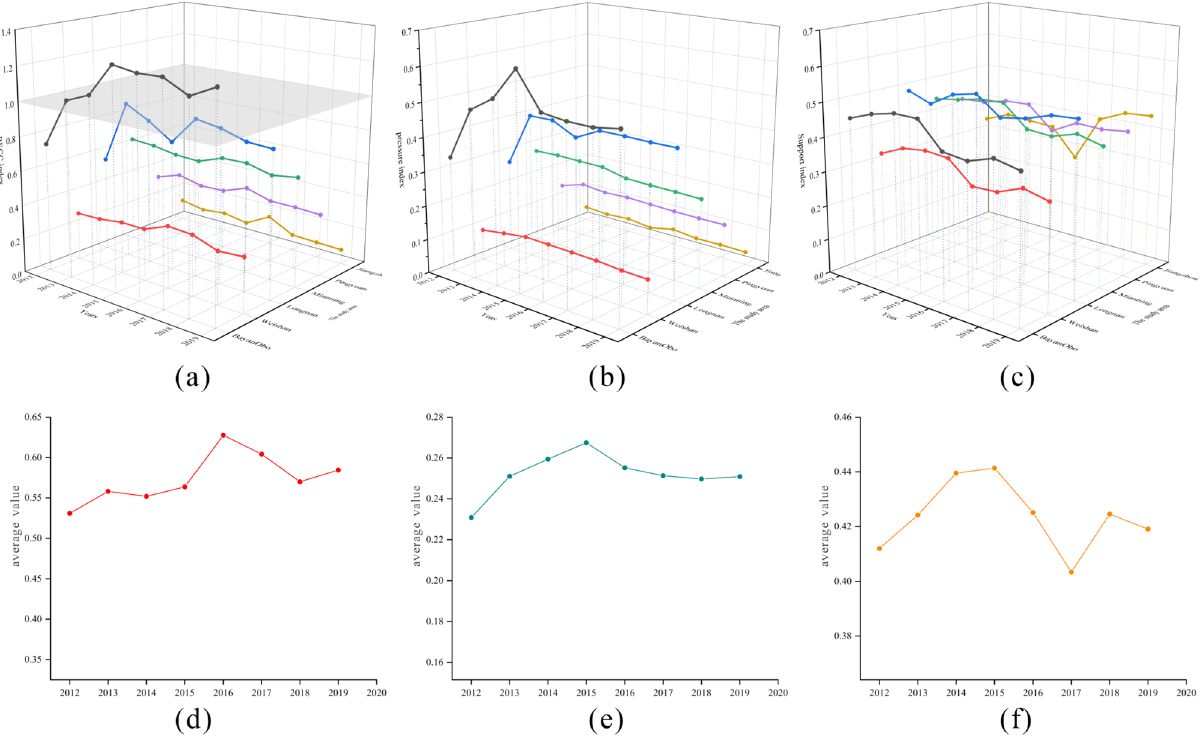
Figure 5. Changes in RECCs for each mine. ( a ) The trend of the RECC index in the mining area; ( b ) The trend of the pressuring index in the mining area; ( c ) The trend of the supporting index in the mining area; ( d ) The trend of average RECC index; ( e ) The trend of average pressuring index; ( f ) The trend of average supporting